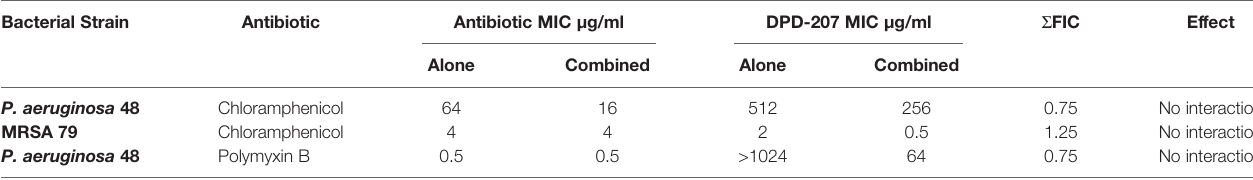
TABLE 2C | Synergistic effects of DPD-207 with antibiotics. Bacterial Strain